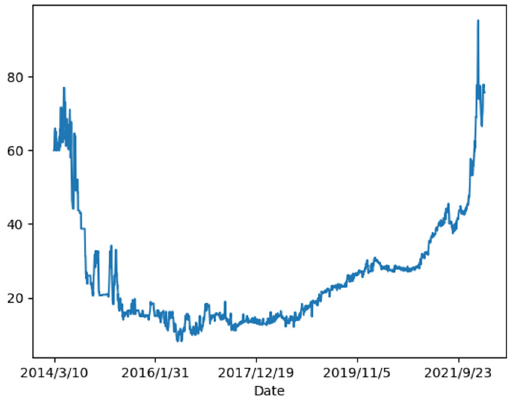
Figure 2. The carbon price of the Guangdong carbon trading market.